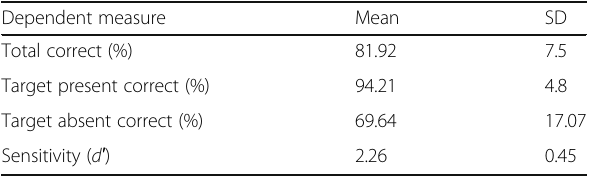
Table 1 Experiment 1: Accuracy and sensitivity for the detection task for the echocardiographers viewing each movie for 3 s ( n = 44) Dependent measure Mean